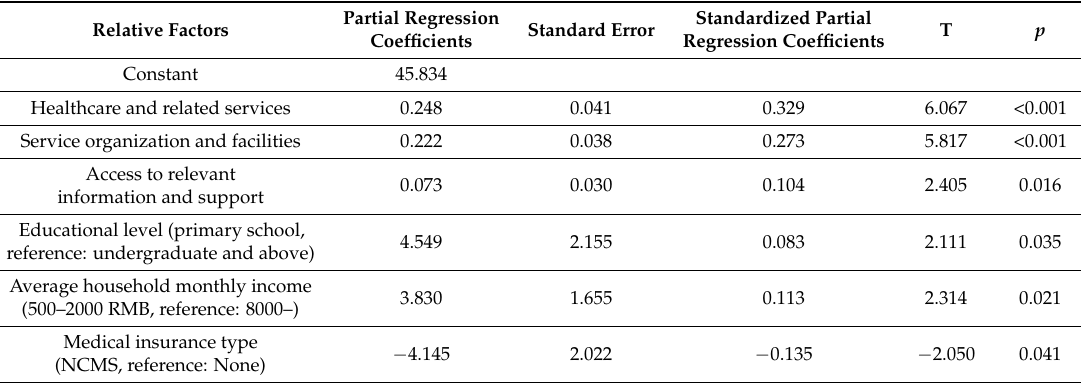
Table 7. Results of multi-factor linear regression analysis for the patients’